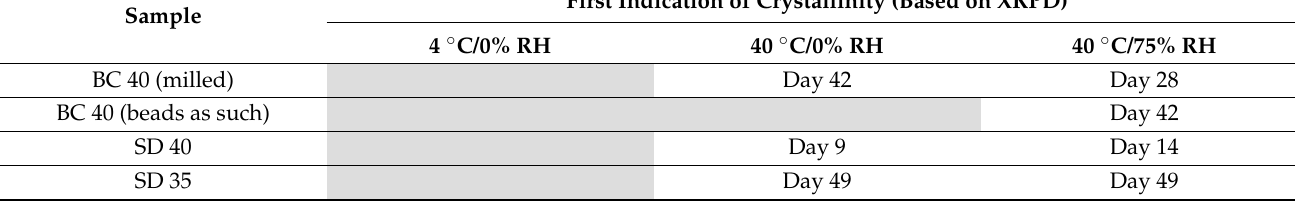
Table 5. Overview of the days upon storage on which crystallinity could first be detected with XRPD, for the NAP_40_PVP-VA formulation coated onto pellets (BC 40), the spray dried NAP_40_PVP-VA formulation (SD 40) and the spray dried NAP_35_PVP-VA system (SD 35), stored at 4 ◦ C/0% RH, at 40 ◦ C/0% RH and at 40 ◦ C/75% RH. Grey boxes imply that no NAP characteristic Bragg peak could be detected after three months of storage.